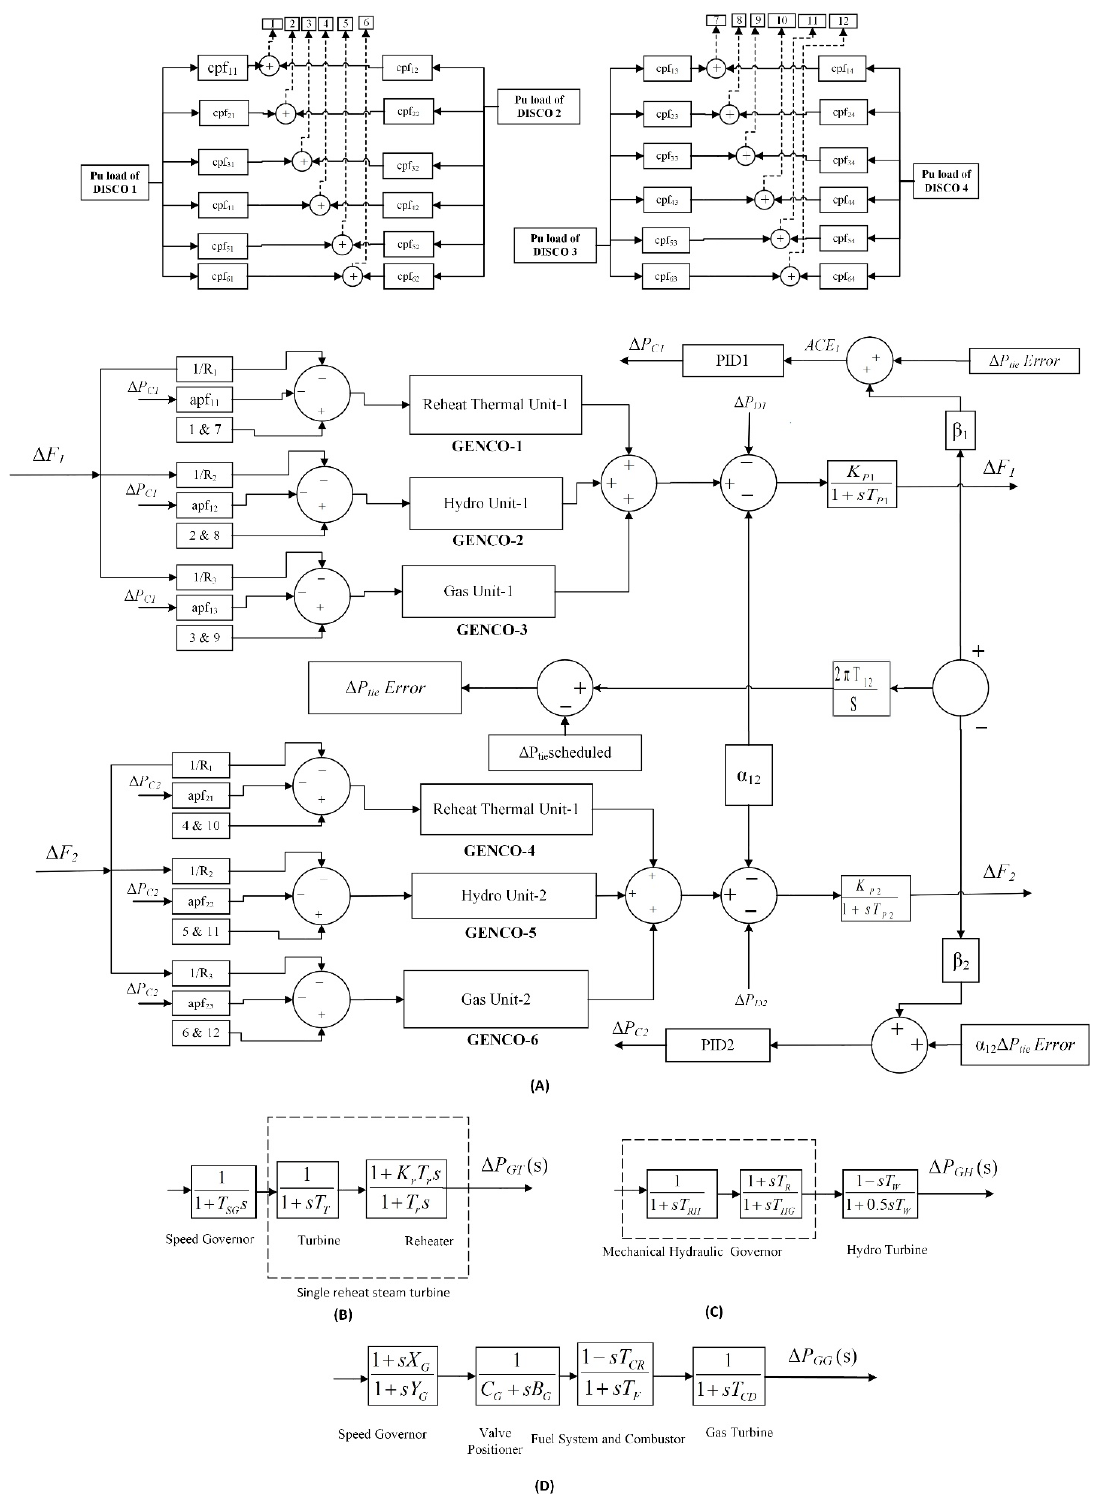
Figure 2. Restructured power system. TFM of ( A ) two-area multi-source restructured power system, ( B ) thermal system, ( C ) hydro system, ( D ) gas system. The corresponding DPM related to three GENCOs along with two DISCOs in area-1 and three GENCOs along with two DISCOs in area-2 is shown in Equation